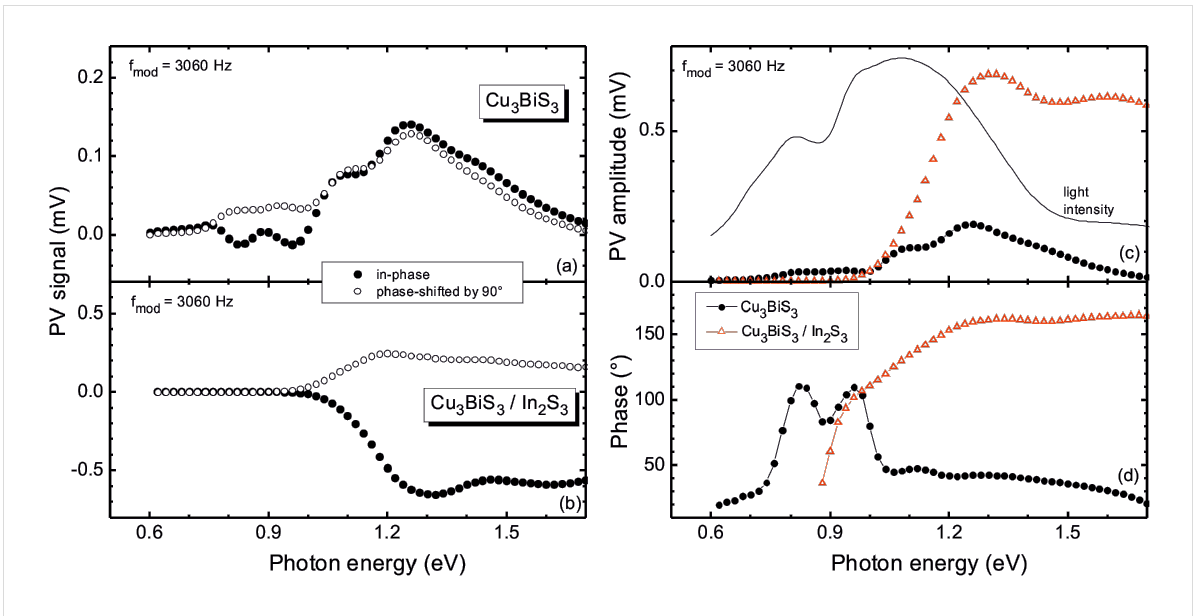
Figure 4: In-phase (solid circles) and 90°-phase-shifted (open circles) SPV spectra of (a) Cu 3 BiS 3 and (b) Cu 3 BiS 3 /In 2 S 3 samples at a modulation frequency of 3060 Hz. From these, spectra of the (c) PV amplitude and (d) phase angle for Cu 3 BiS 3 (solid circles) and Cu 3 BiS 3 /In 2 S 3 (open triangles) samples were derived. The solid line in (c) gives the light